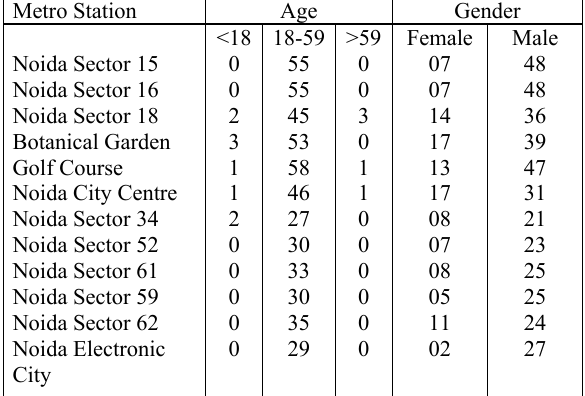
Table 1 . Frequency Distribution of identified Metro station samples.